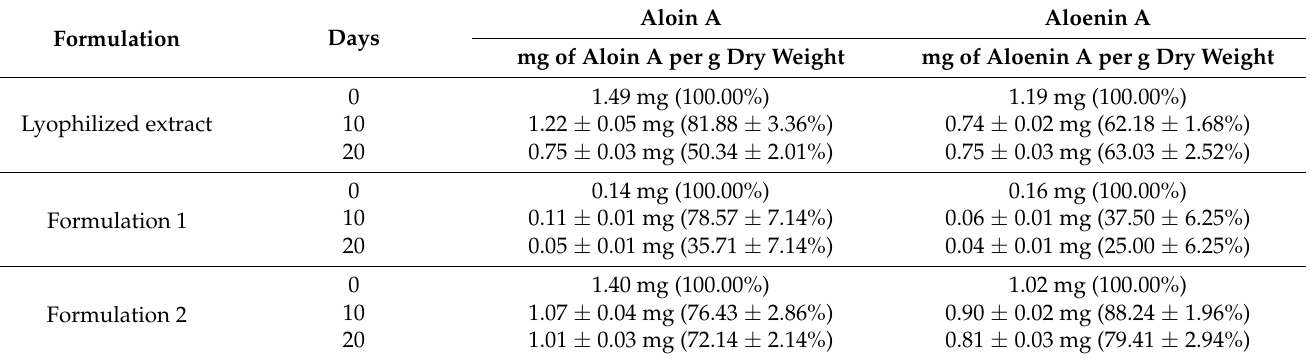
Table 6. Stability of aloin A and aloenin A.